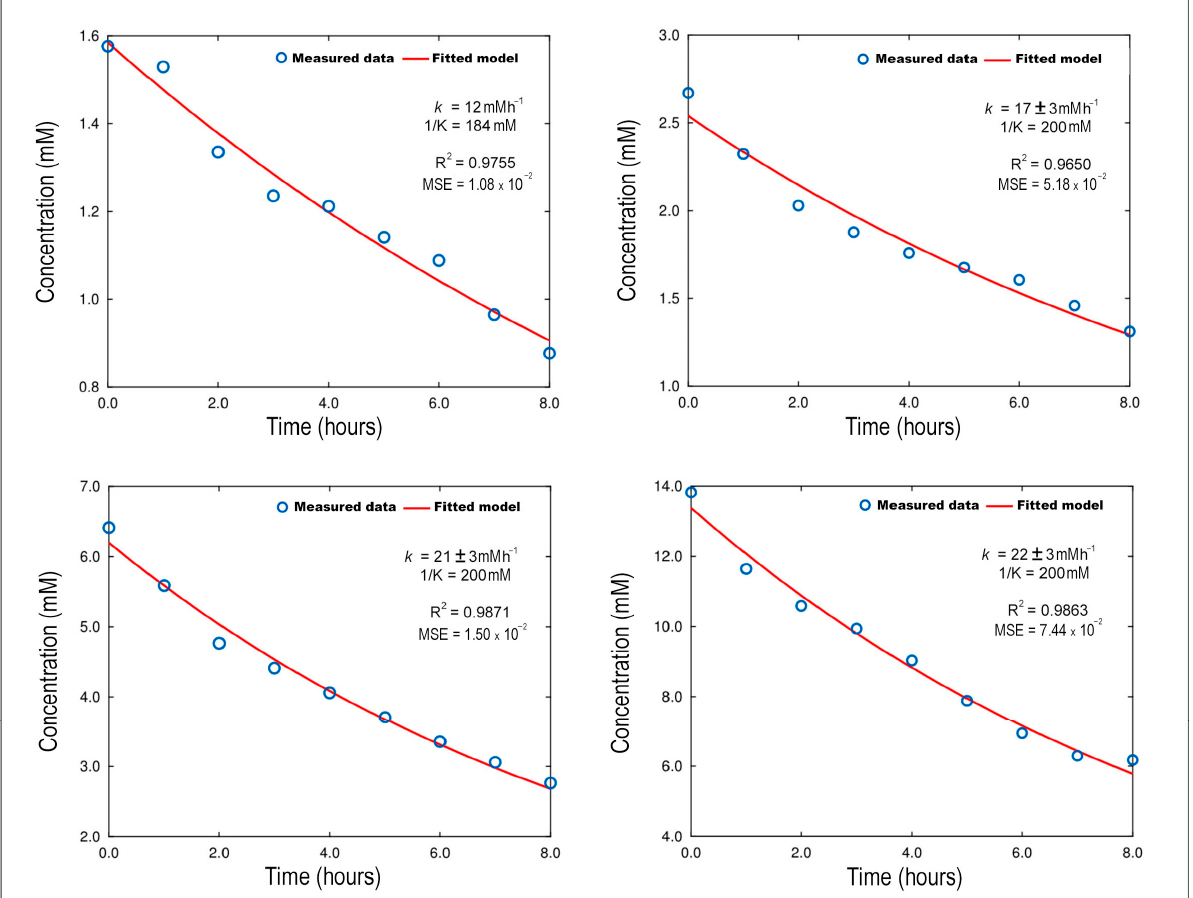
Figure 9. Fit to the integrated Langmuir–Hinshelwood rate equation of the experimental data C t ( t ) of the ammonia removal photocatalytic process at different initial ammonia concentrations (pH = 11.0, P = 25 W, Q = 1000 L/h, temperature = 20 ± 1 ◦